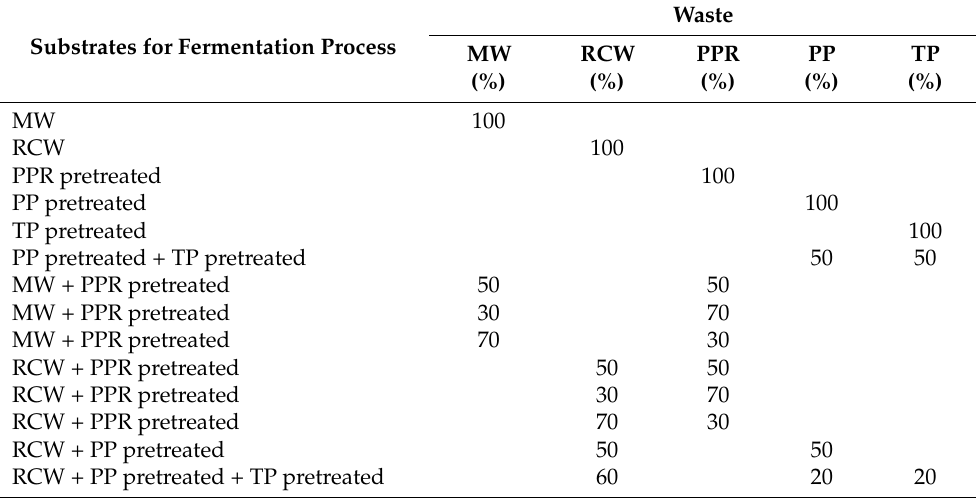
Table 2. Substrates used for fermentation, as single biomasses or mixtures of